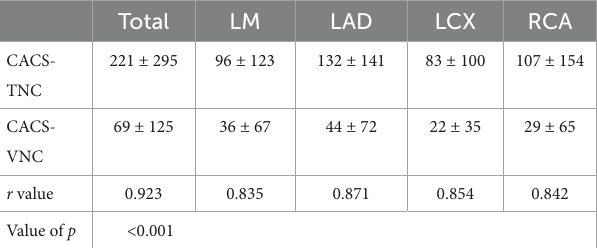
The CACS-TNC represents the coronary artery calcium scores from the conventional non- contrast images. The CACS-VNC represents the coronary artery calcium scores from the virtual non-contrast images. The CACS-VNC represents the coronary artery calcium volume from virtual non-contrast images. Total, the overall coronary artery; LM, left main coronary artery; LAD, left anterior descending branch; LCX, left circumflex branch; RCA, right coronary artery. Values are mean ±